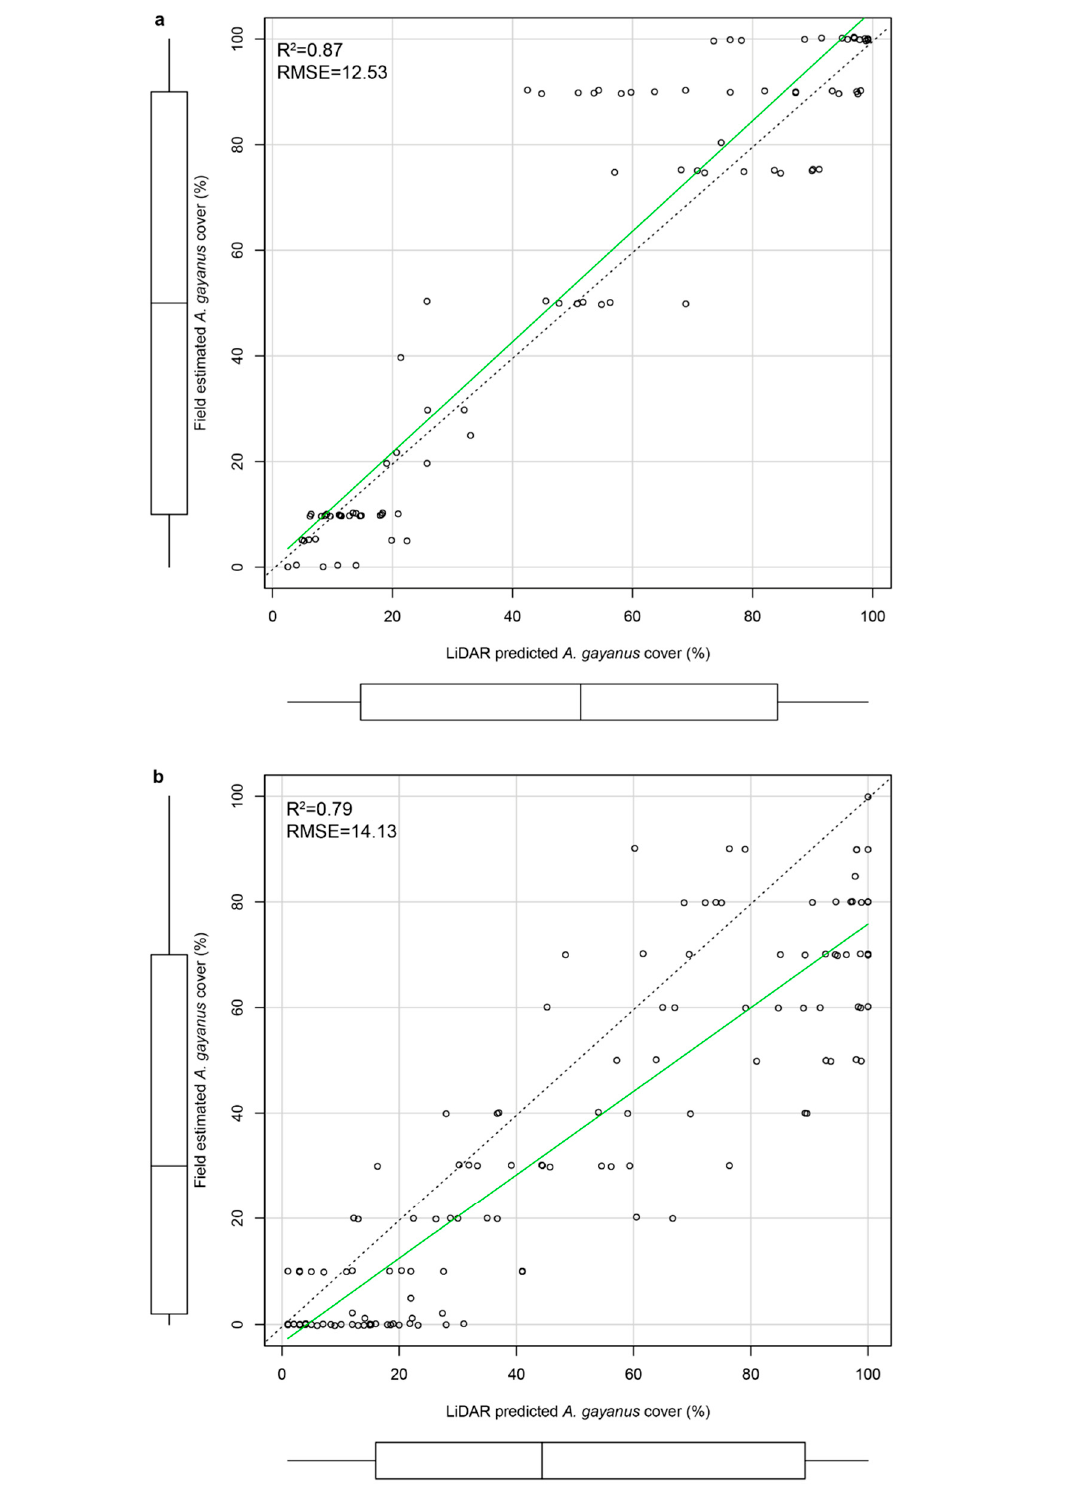
Figure 5. Validation of LiDAR estimated A. gayanus coverage against field-based estimates at ( a ) 500 m 2 scale and ( b ) 100 m 2 scale. Solid green line represents the ordinary least squares regression, and the 1:1 line is indicated by the dotted black